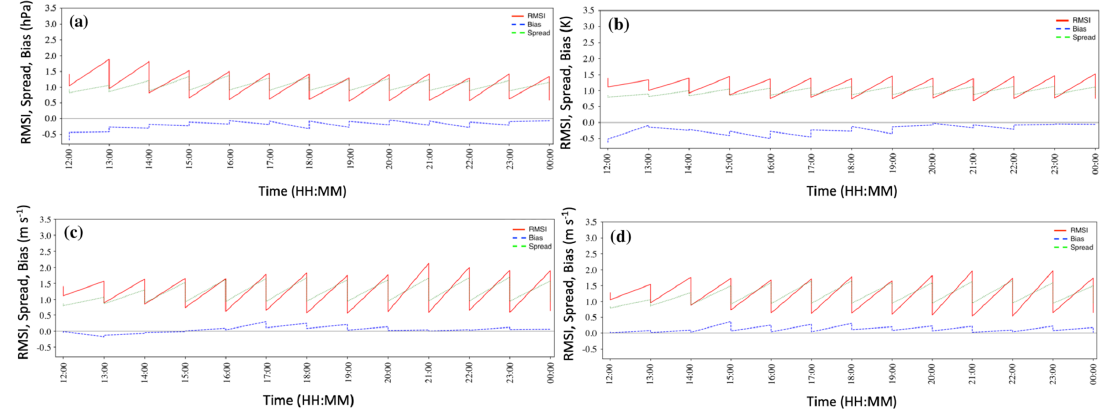
Figure 7. Sawtooth plots depicting the evolution of the RMSI, bias and total spread during the assimilation window for the METAR (a) al- timeter and (b) temperature observations and for the RSAMV (c) U wind and (d) V wind observations.